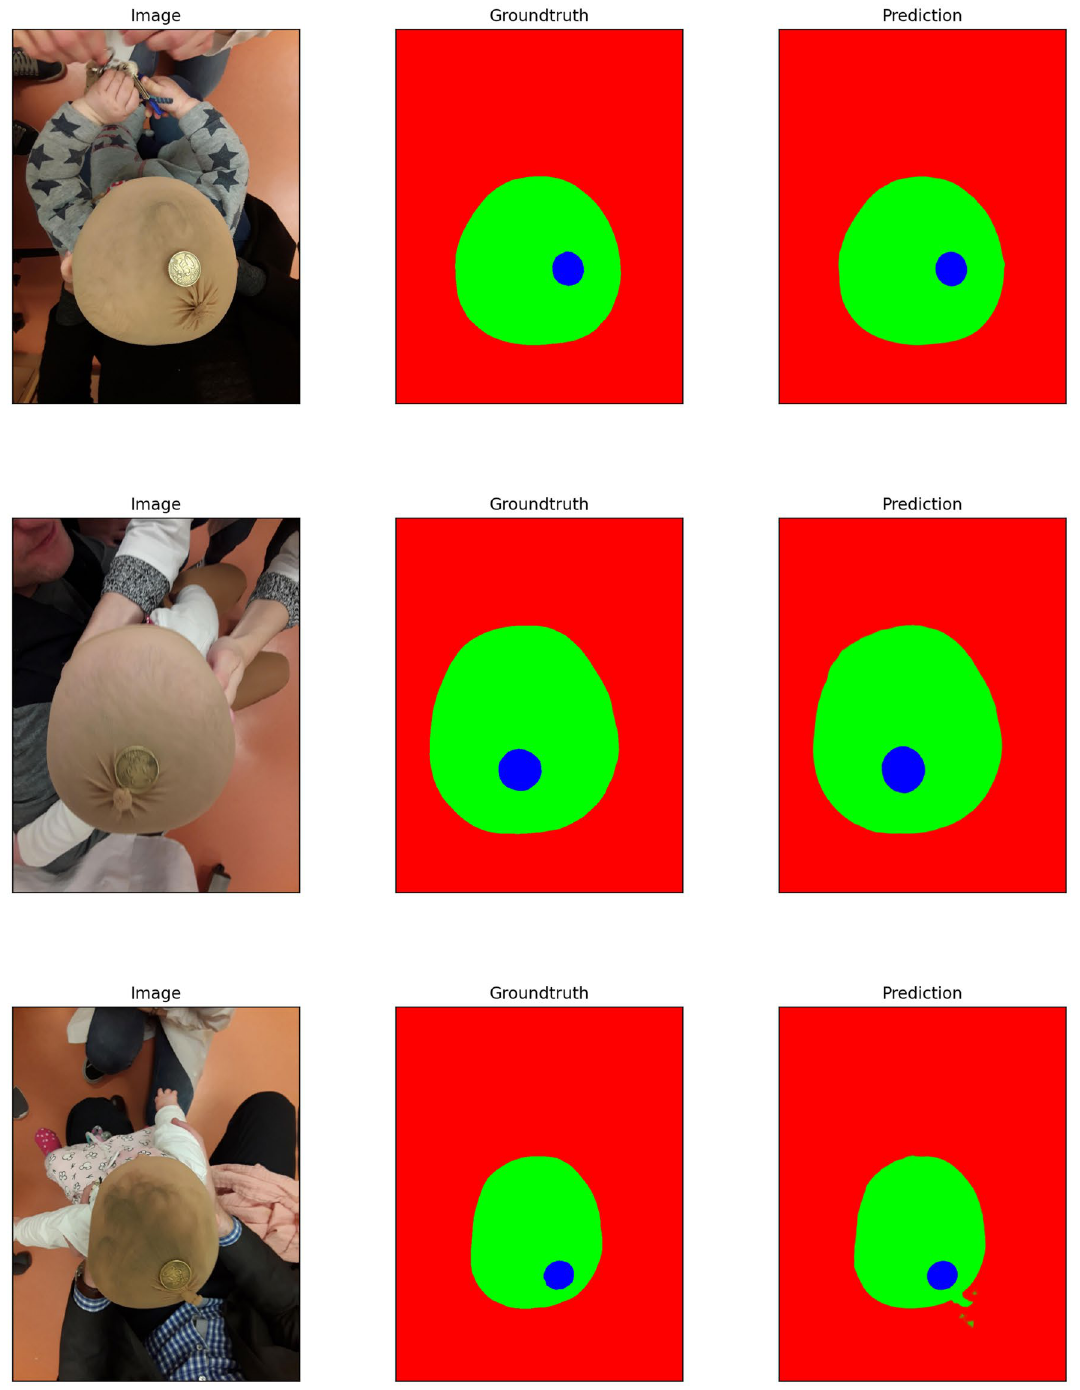
Figure 2. Examples of images with applied segmentation technique. The first image from top contains the coin almost in the middle and the segmentation result is done perfectly. In the second image the coin is not aligned with the center of the head although the segmentation is performed impeccably. The last image (image in bottom contains the coin connected with the tie of the covering head so, some outlier are detected